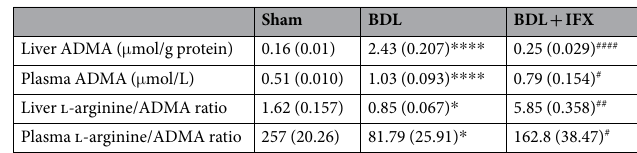
Table 3. Liver and plasma l-arginine and ADMA measurements. Data are shown as mean (standard error). * p < 0.05, **** p < 0.0001 compared to Sham. # p < 0.05, ## p < 0.01 , #### p < 0.0001 compared to BDL. (Sham n = 10; BDL n = 10; BDL + IFX n =